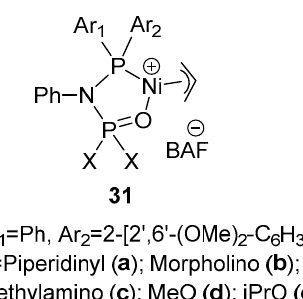
Figure 28. Phosphine phosphonic amide nickel catalysts 31a – e .